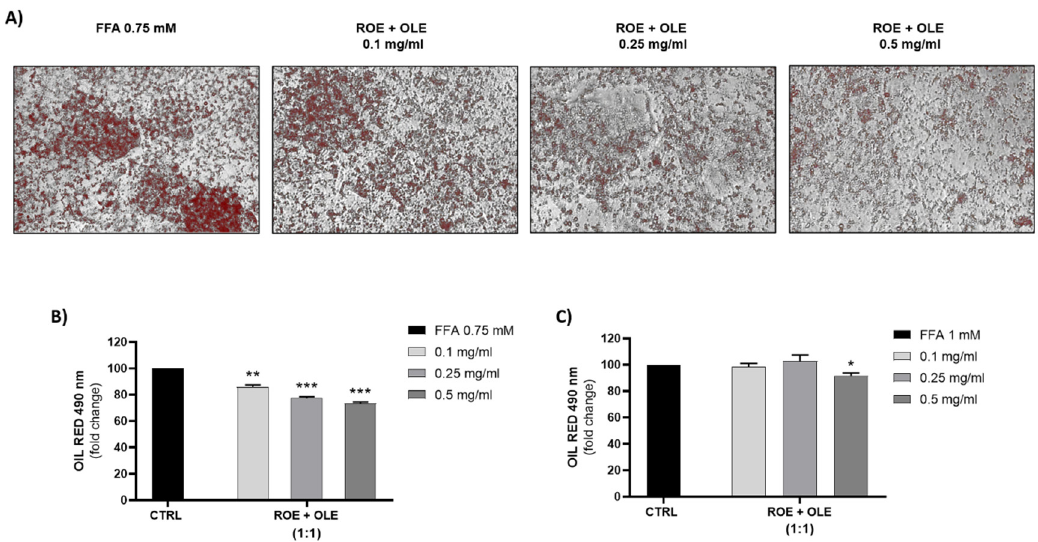
Figure 4. ( A ) Representative images of Oil Red O’ staining on HepG2 treated for 72 h with FFA 0.75 mM and different 1:1 combination of ROE and OLE ( B , C ). Effect of 1:1 combinations of ROE and OLE on lipid droplets accumulation in the presence of FFA 0.75 mM and 1 mM. Significant vs CTRL: * p < 0.05; ** p < 0.005; *** p < 0.0005.